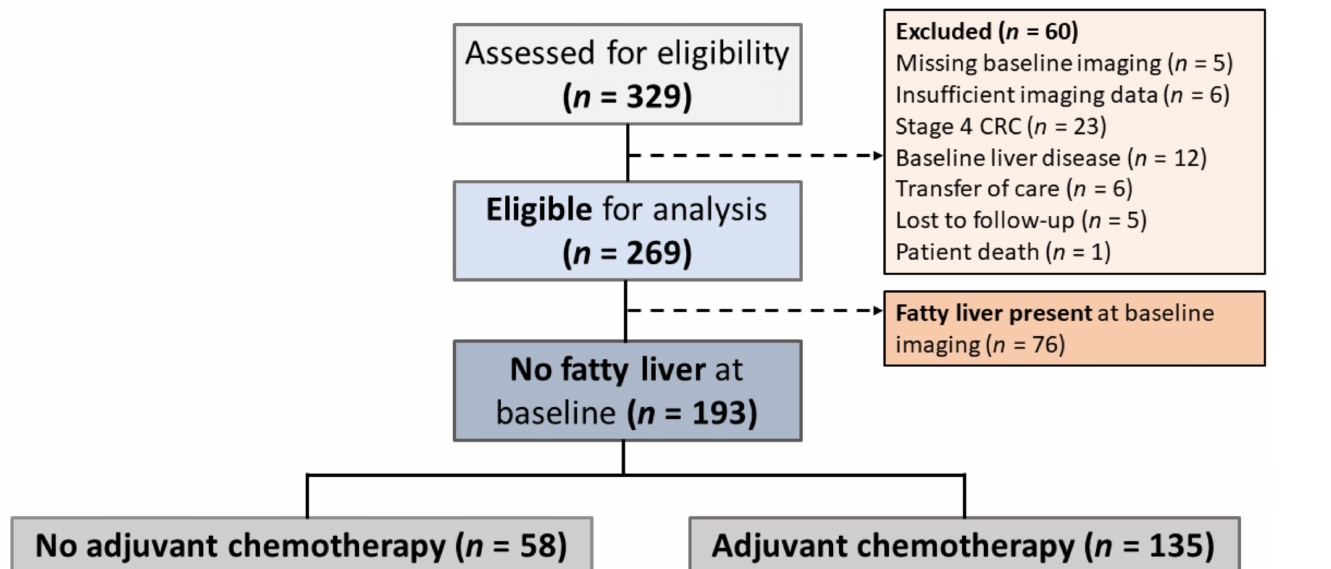
Figure 1. Study Participant Selection. Stage II–III colorectal cancer (CRC) patients were screened for eligibility prior to data collection, and those in whom fatty liver was present at baseline were excluded from further analyses. The 187 patients who did not have signs of hepatic steatosis at baseline were further divided into two groups based on their receipt of adjuvant